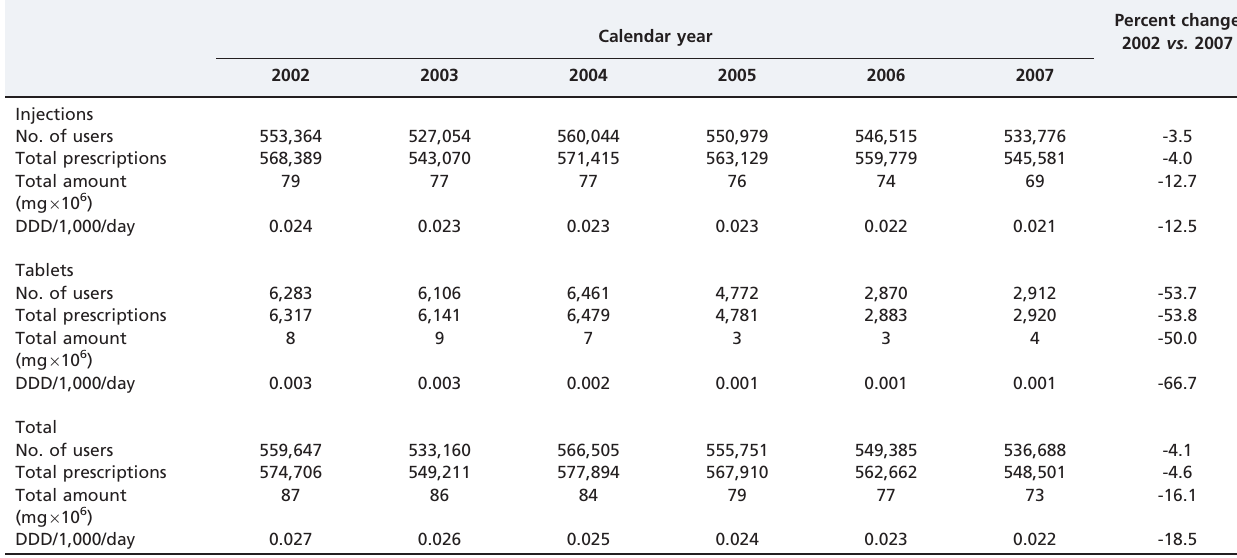
Table 1 - Numbers of pethidine users, total prescriptions, total amounts, and defined daily dose, 2002-2007.